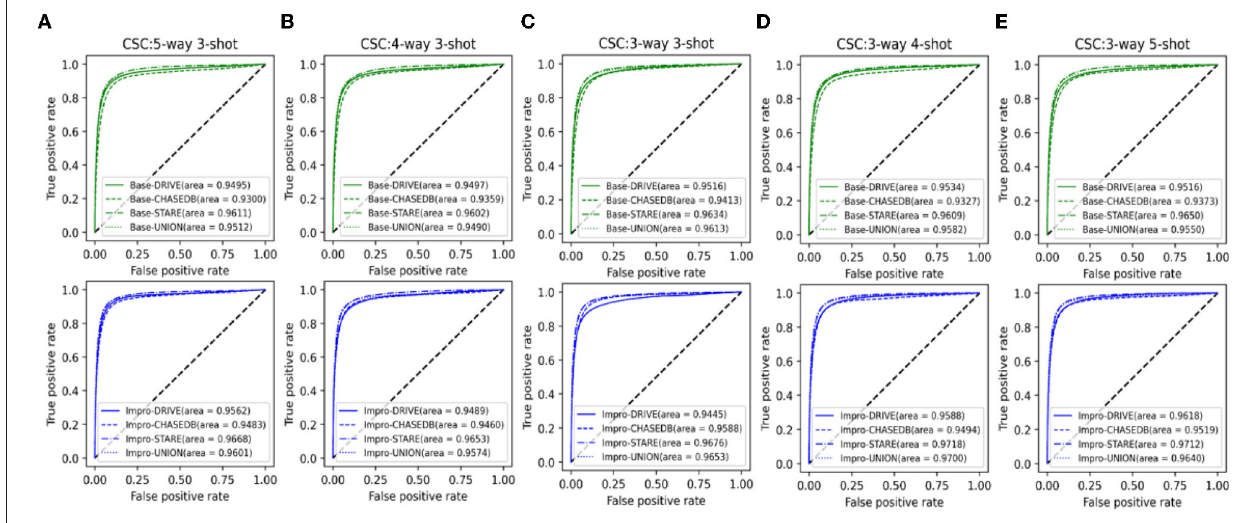
FIGURE 13 | Comparison of the domain adaptability based on the AUC: (A) 5-way 3-shot; (B) 4-way 3-shot; (C) 3-way 3-shot; (D) 3-way 4-shot; and (E) 3-way 5-shot.